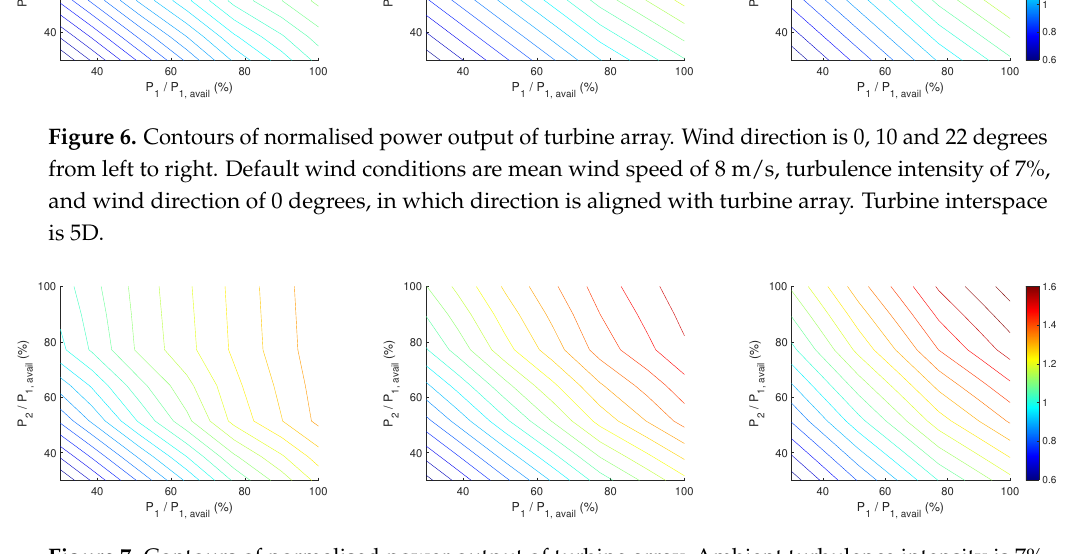
Figure 7. Contours of normalised power output of turbine array. Ambient turbulence intensity is 7%, 14% and 27% from left to right. Default wind conditions are mean wind speed of 8 m/s, turbulence intensity of 7%, and wind direction of 0 degrees, in which direction is aligned with turbine array. Turbine interspace is 5D.